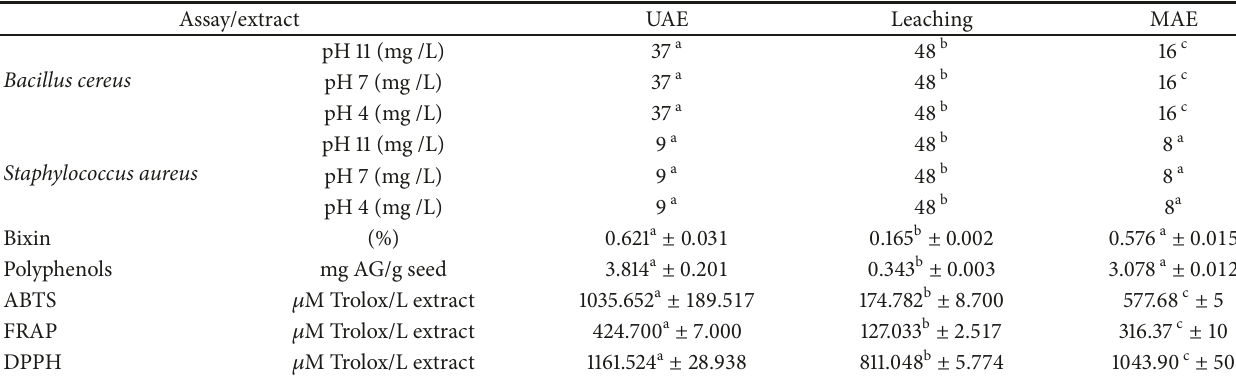
Table 4: Minimum inhibitory concentration (MIC) at different pHs against B. cereus and S. aureus and antioxidant activity of the extracts obtained by UAE and